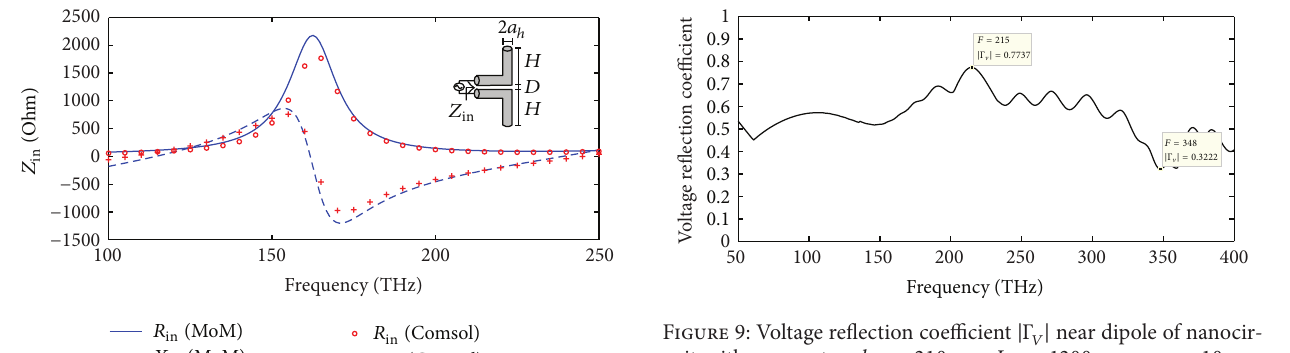
= 10 , 𝑁 = 40 , Δ𝐿 = 30 nm, ℎ 𝐿 𝐿